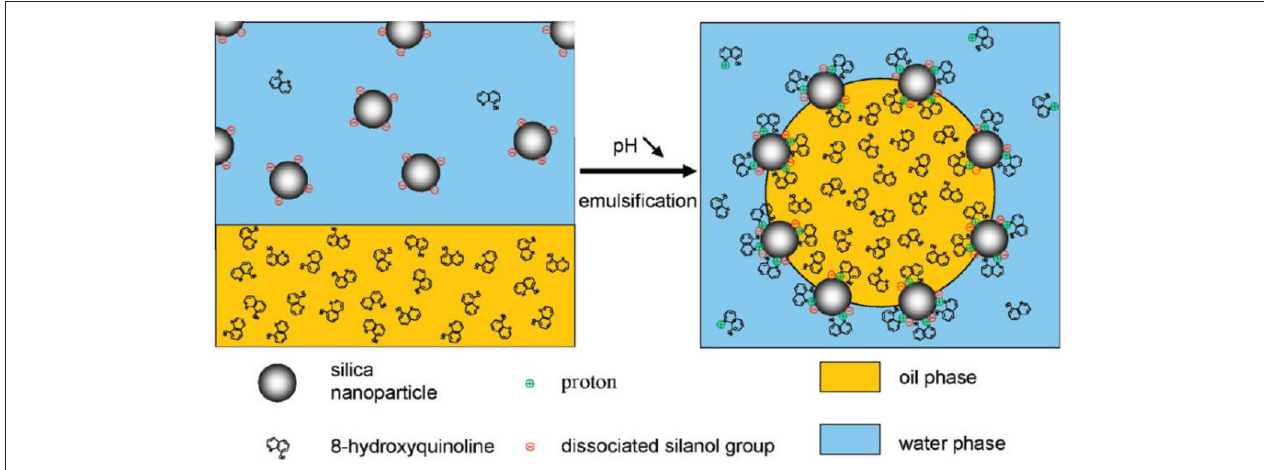
FIGURE 1 | Schematic representation of pH-sensitive Pickering emulsion stabilized by silica nanoparticles and hydrophobizing agent 8-hydroxyquinoline (8-HQ) (Haase et al., 2010). Reprinted with permission from Haase et al. (2010). Copyright 2010 American Chemical Society.